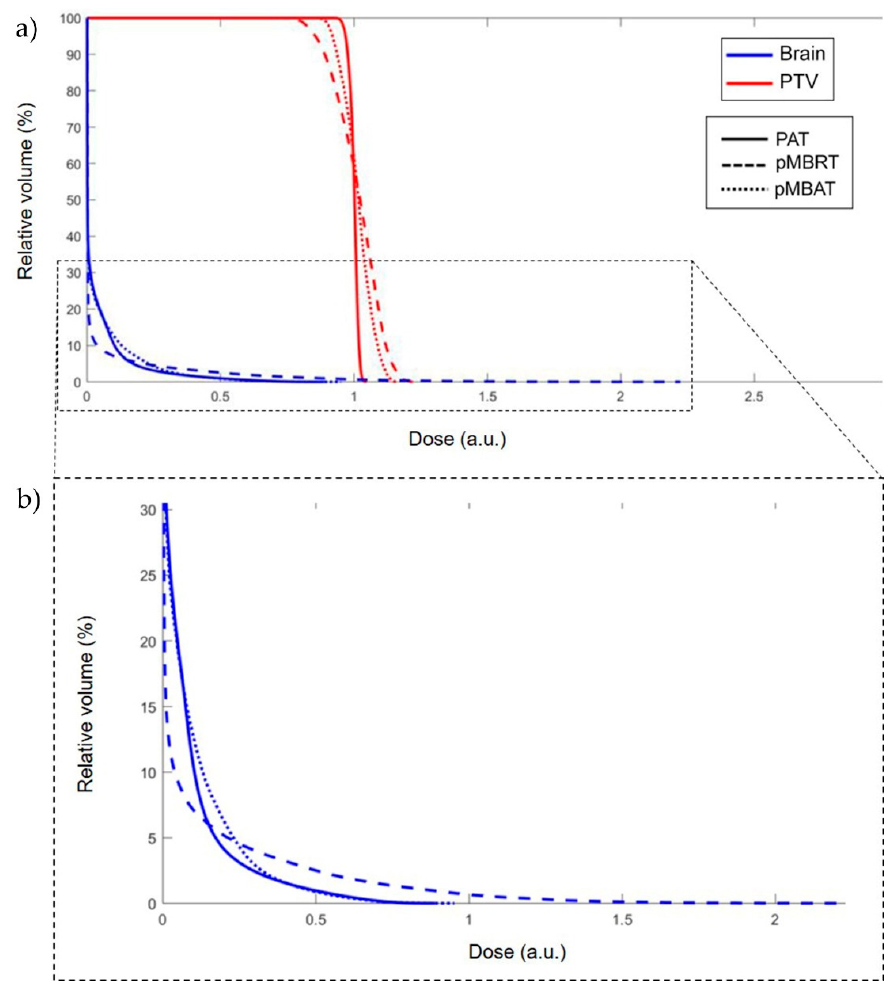
Figure 6. ( a ) DVH for pMBRT, PAT and pMBAT treatments. ( b ) Zoomed in view of ( a ). Doses are normalized to the same average dose to the PTV. Table 2. Integral doses on the PTV and brain